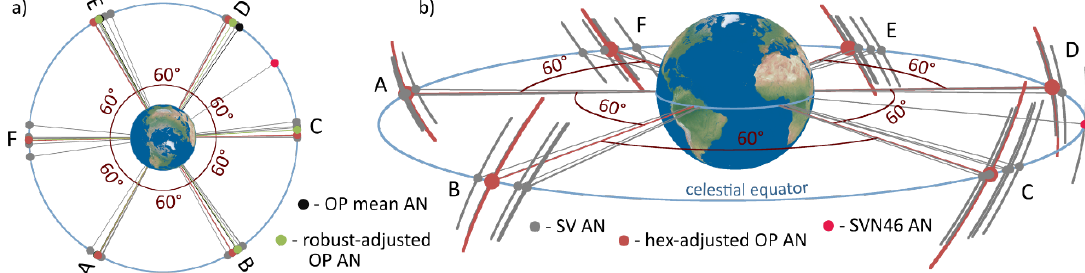
Figure 4. Position estimators of OP ANs determined by the robust estimation method and hex-LS on 13 September 2020 in top ( a ), and perspective view ( b ).